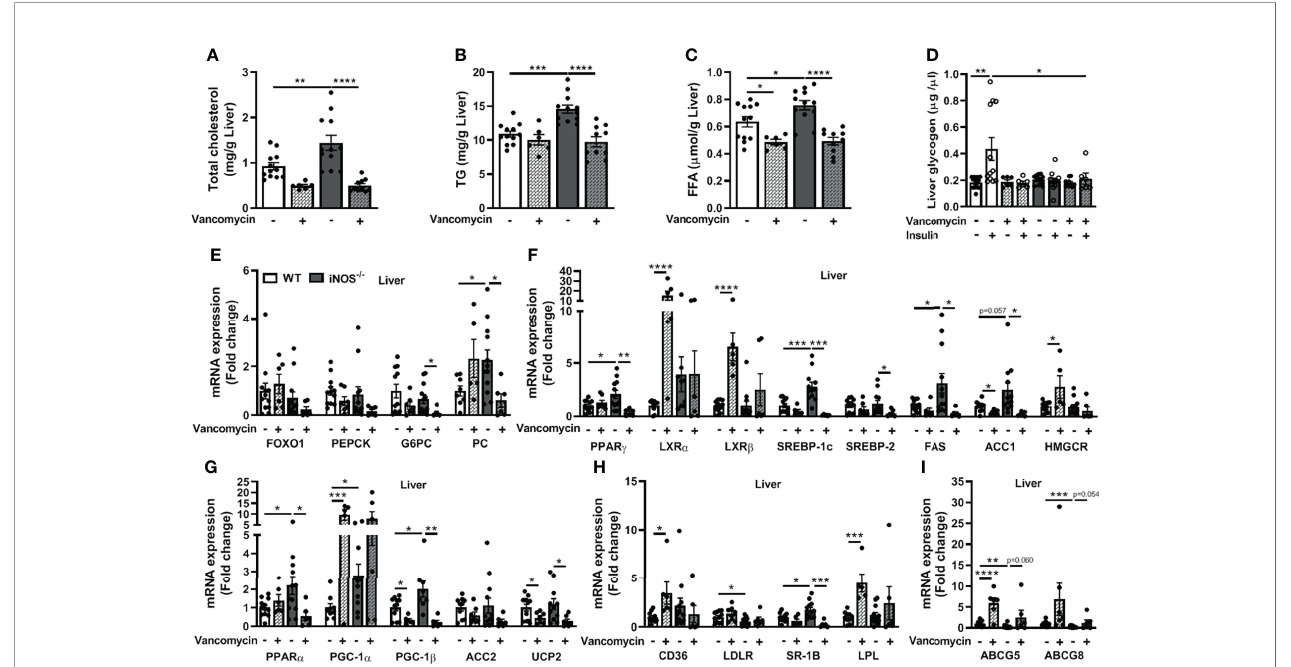
FIGURE 4 | Improvement in the disrupted lipid and glucose homeostasis in the liver in iNOS − / − mice following treatment with vancomycin. Hepatic lipid levels in WT and iNOS − / − mice with and without vancomycin treatment: (A) TC, (B) TG, and (C) FFA. (D) Hepatic glycogen levels with or without insulin stimulation in WT and iNOS − / − mice with and without vancomycin treatment. Hepatic mRNA expression analysis of genes involved in (E) gluconeogenesis, (F) lipid synthesis, (G) lipid oxidation, (H) lipid uptake, and (I) lipid ef fl ux. Data are represented as mean ± SEM ( n ≥ 6). * p < 0.05, ** p < 0.01, *** p < 0.001, **** p < 0.0001 between indicated groups. See also Figure S7